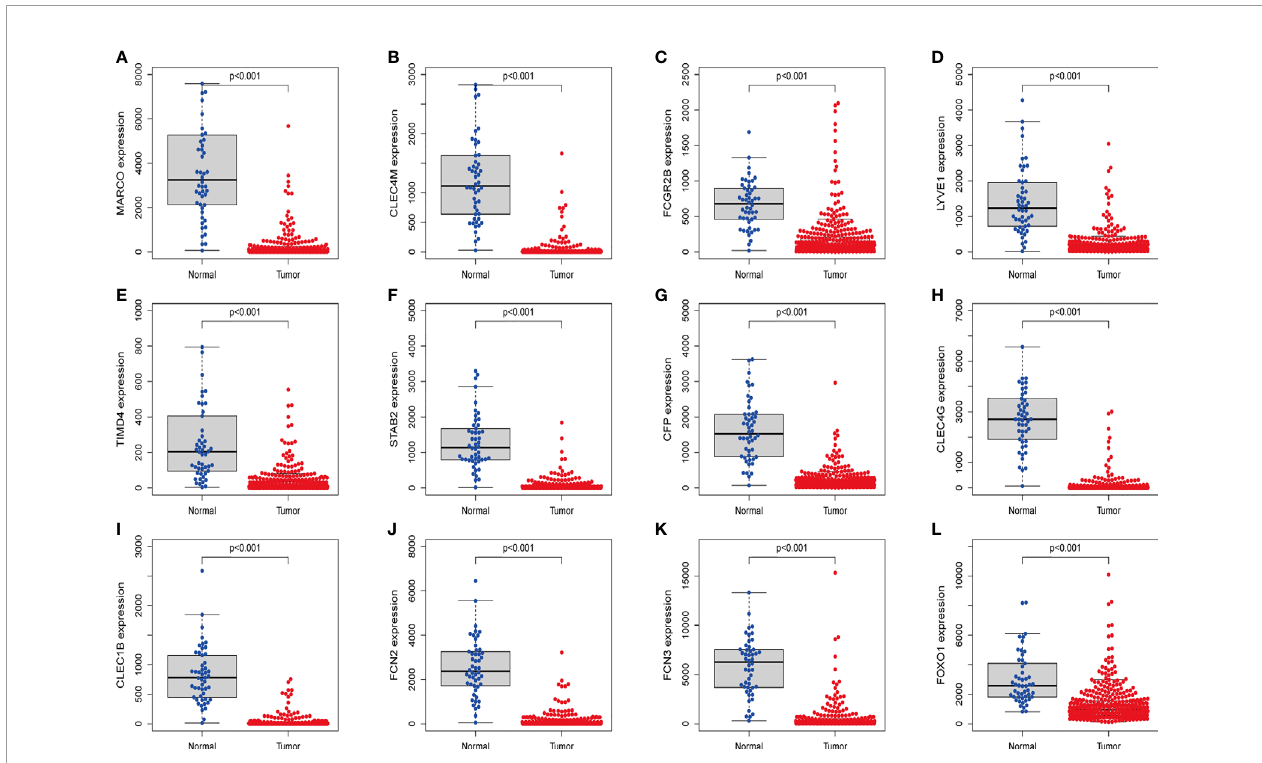
FIGURE 9 | Validation of expression levels of hub genes among HCC and normal tissues from the TCGA database. (A) MARCO, (B) CLEC4M, (C) FCGR2B, (D) LYVE1, (E) TIMD4, (F) STAB2, (G) CFP, (H) CLEC4G, (I) CLEC1B, (J) FCN2, (K) FCN3 and (L)